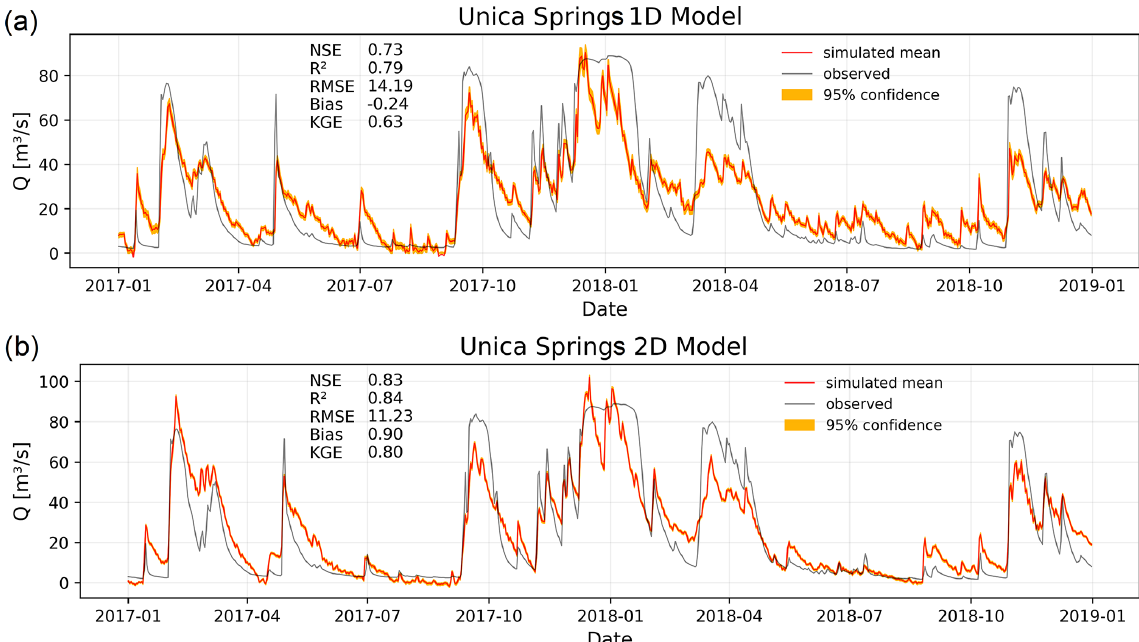
Figure 4. Simulation results for 2017–2018 at Unica springs in Slovenia using climate station input data (a) and E-OBS gridded data (b)